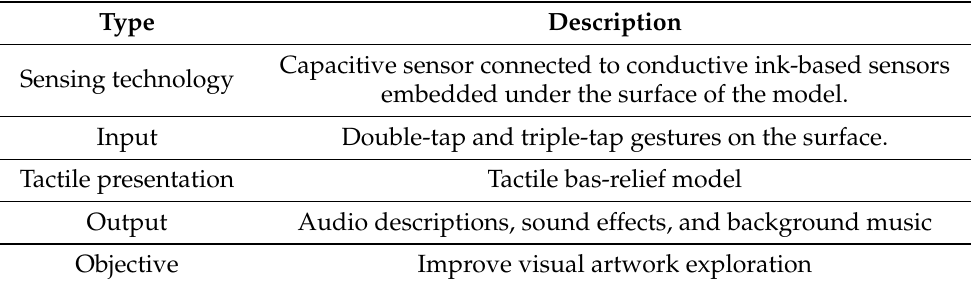
Table 1. Interactive multi-modal guideline for appreciating visual artworks and museum objects [25]. Type Capacitive sensor connected to conductive ink-based sensors embedded under the surface of the